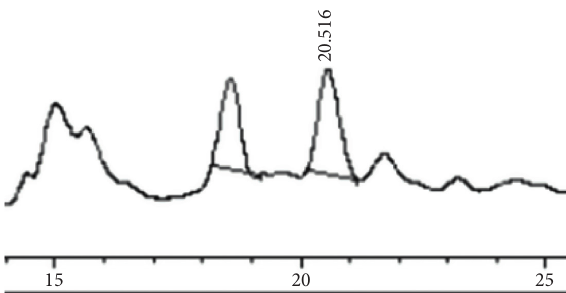
Figure 4: HPLC chromatogram obtained from 75% v / v ethanol extract (EE) using a mobile phase of 0.1% v / v formic acid :methanol (10: 90, v / v ). Conditions: UV-absorbance detection at 240nm, flow rate 0.3 ml/min and ReproSil-Pur ODS (250mm × 4.6 mm i.d., 5 μ m) column (25 ° C).